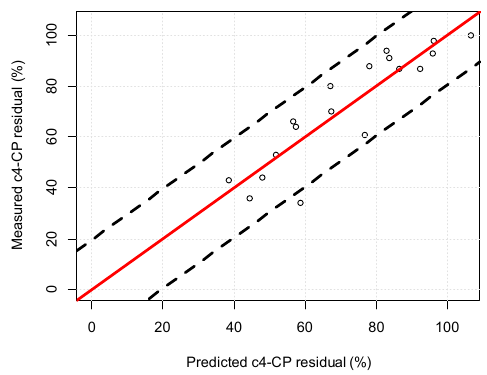
Figure 5. Evaluation of the model: location of the observations in the confidence interval.